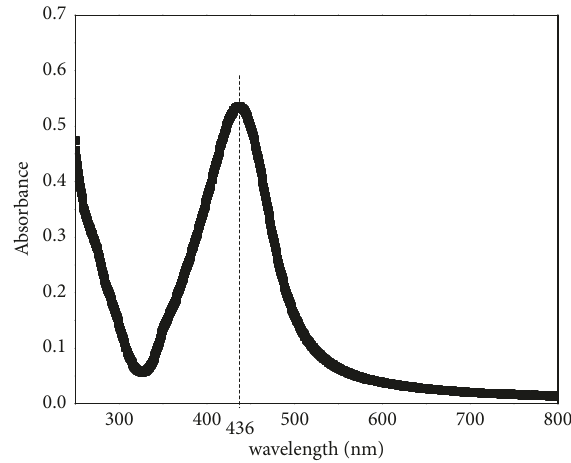
Figure 1: Image taken using TEM of the AgNPs and particle size histogram. Mean size: 32 ± 10 nm .